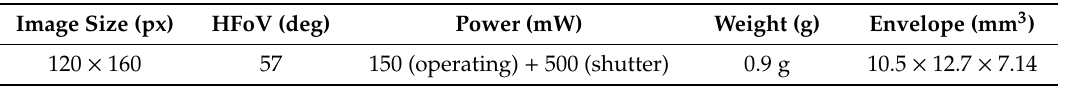
Table 2. Physical characteristics of the IR camera core, FLIR Lepton ® 3, taken as a baseline for a nanosatellite targeted implementation of our horizon sensor